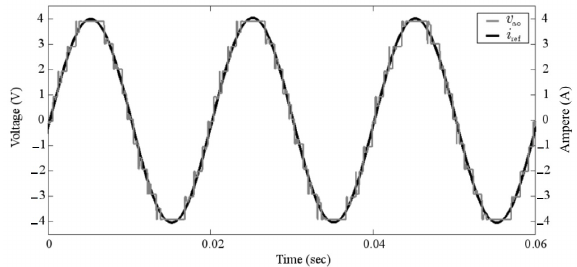
Figure 2. Nine-level inverter output